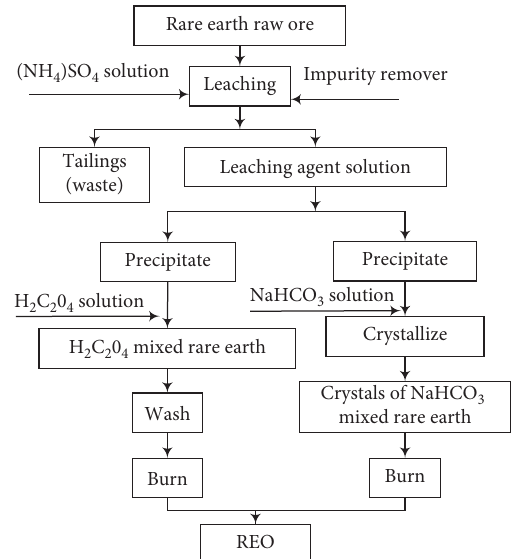
Figure 2: Weathered crust elution-deposited rare earth ore second- generation